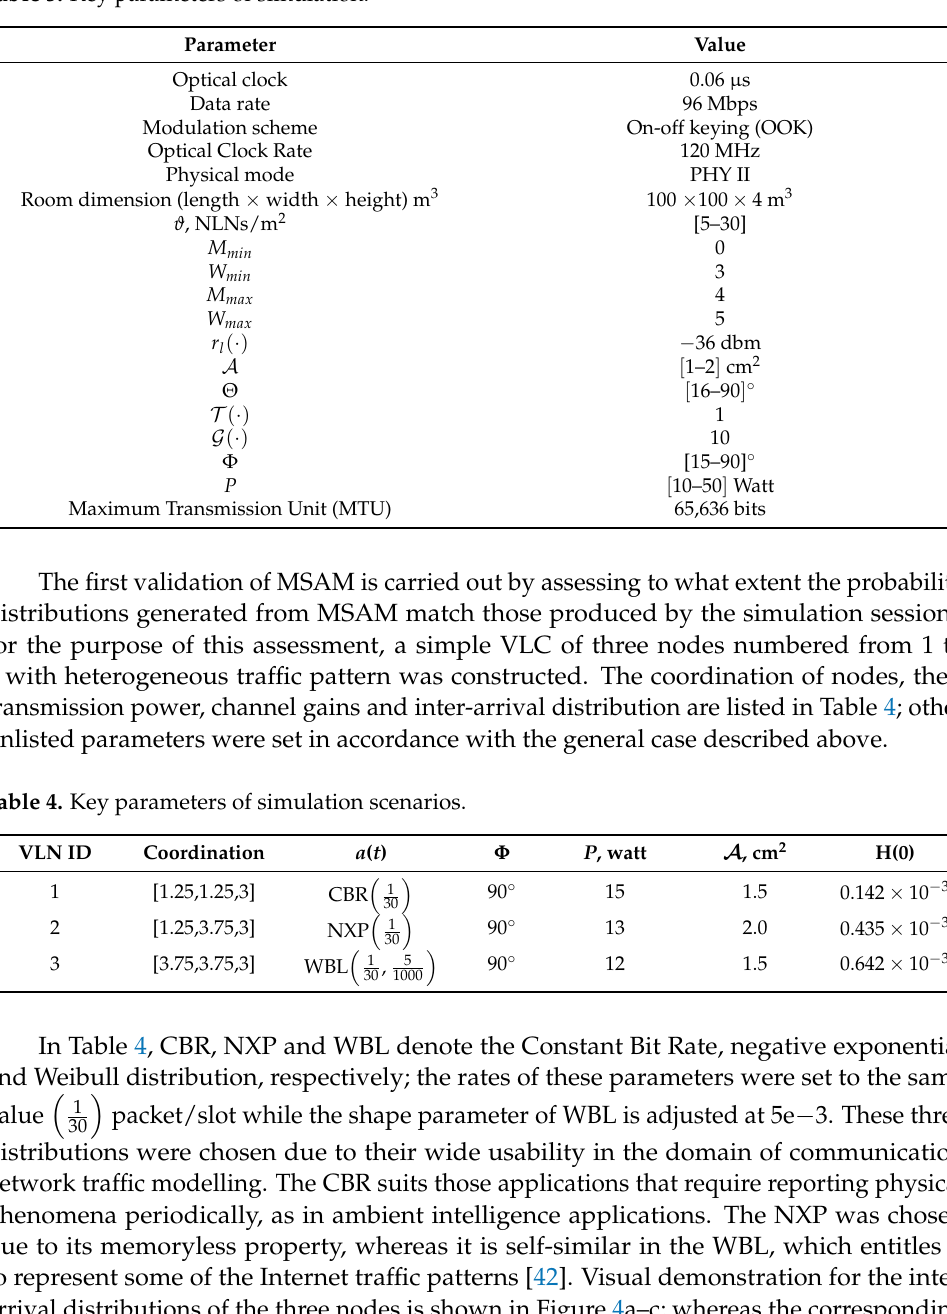
Table 3. Key parameters of simulation.